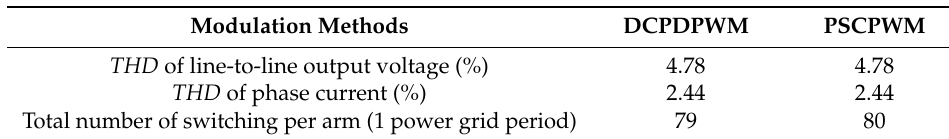
Table 3. Comparison of simulation results between DCPDPWM and PSCPWM method with the output voltage harmonics minimization scheme.